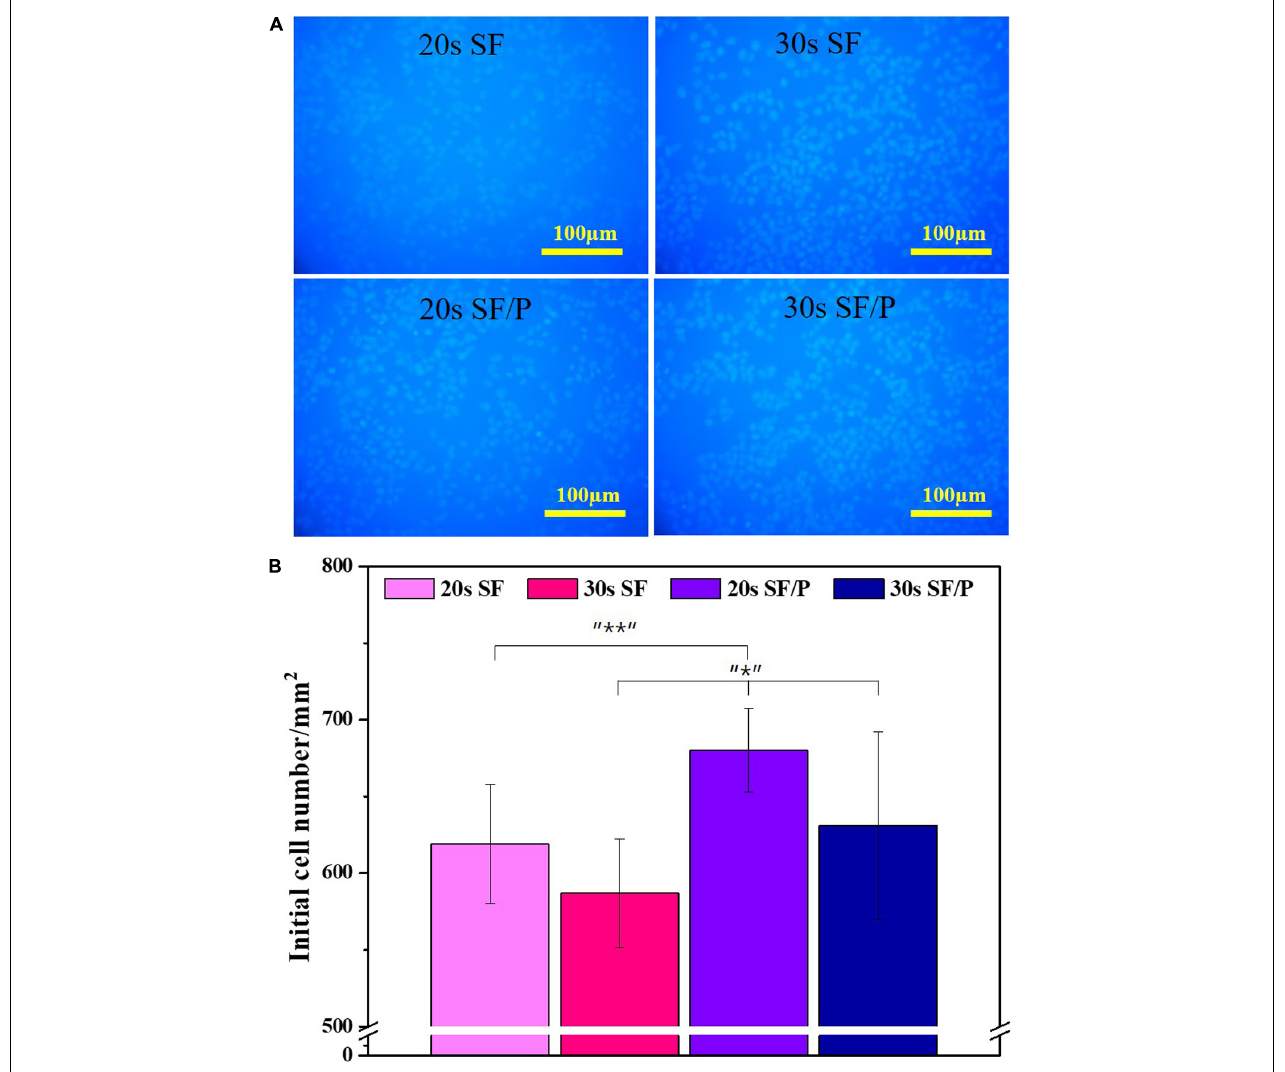
FIGURE 3 | (A) Initial attachment Nuclear stain photograph, (B) initial attachment cell number graph on SF and SF/P hydrogels (Magnification is 200 × ; scale bar = 100 µ m; n = 3 in each group; * p < 0.5, ** p < 0.05, and *** p <